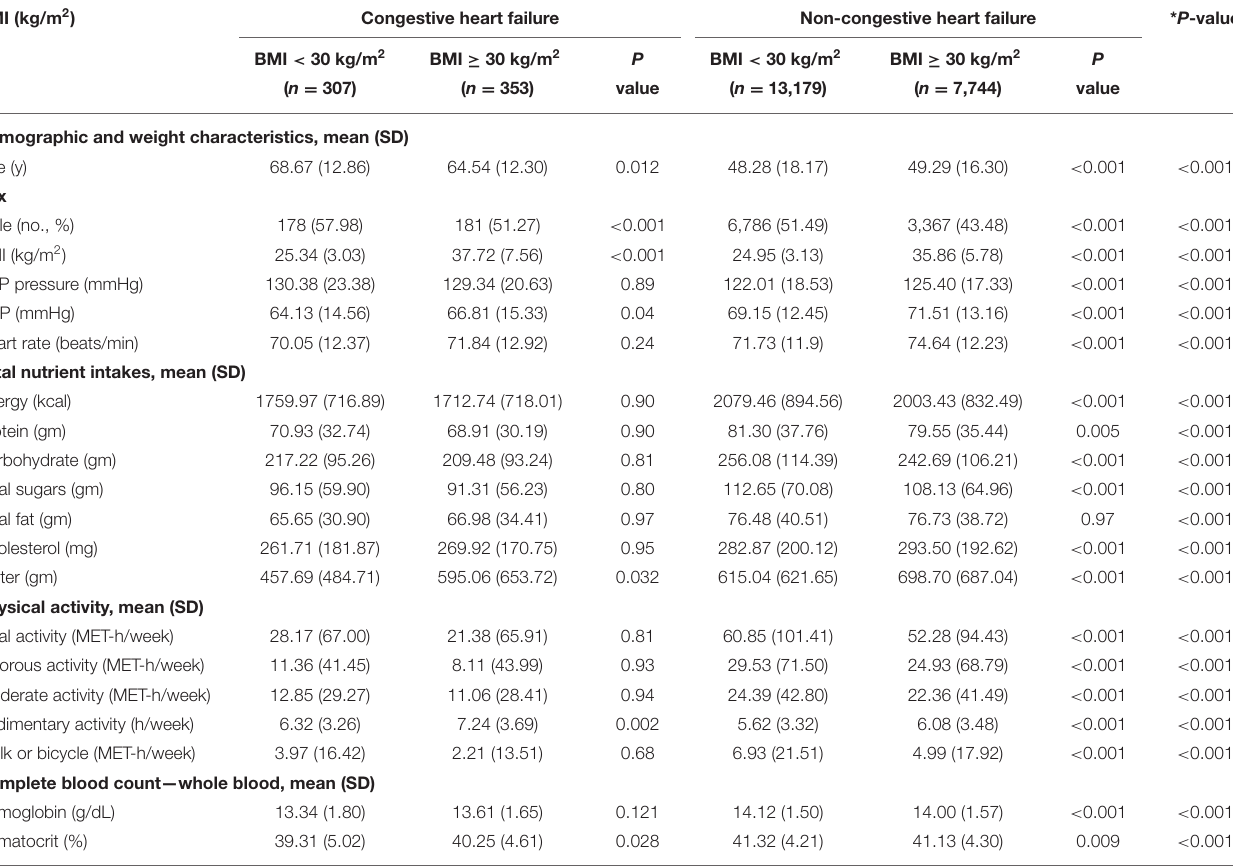
TABLE 2 | Characteristics of congestive heart failure group and non-congestive heart failure group (stratified by obese and non-obese). BMI (kg/m 2 ) Congestive heart